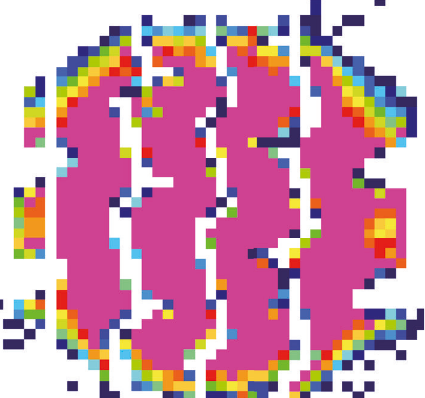
Figure 9: Tire contact distribution.